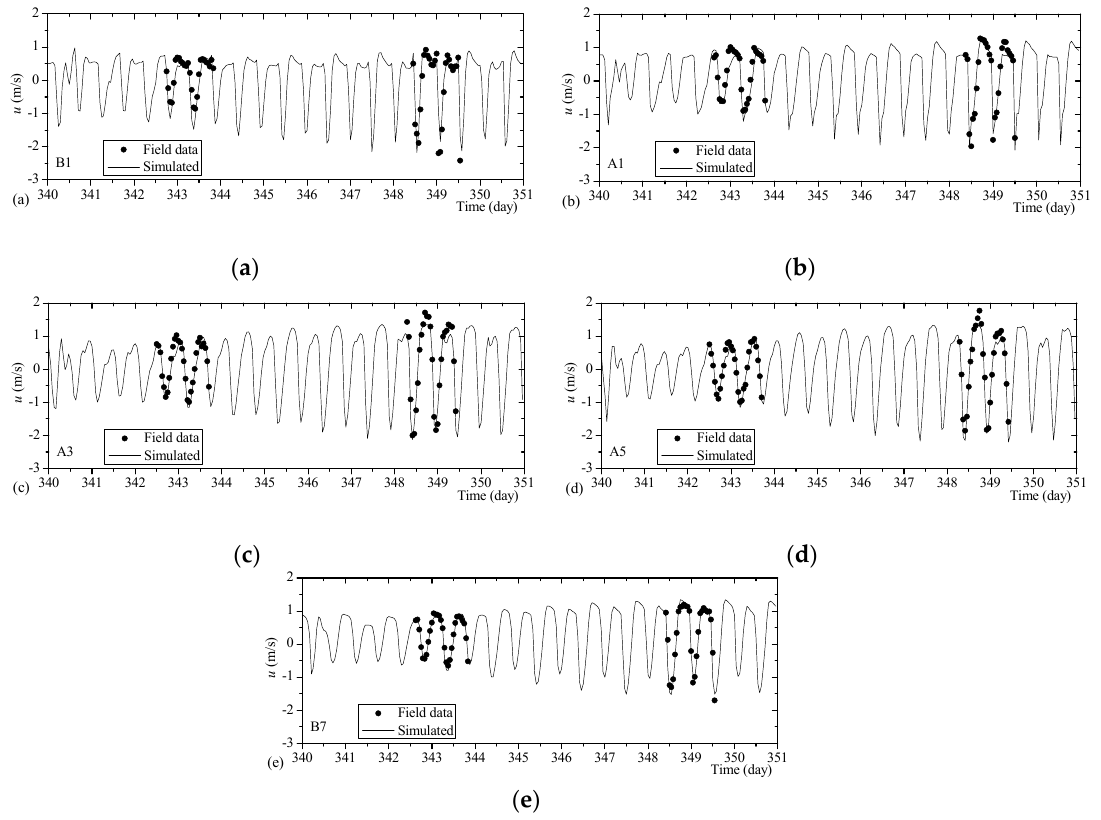
Figure 5. Comparisons of simulated histories of velocity with field data (negative velocity is landward velocity, which appears during the flood duration). ( a ) at Survey Point B1, ( b ) at Survey Point A1, ( c ) at Survey Point A3, ( d ) at Survey Point A5, ( e ) at Survey Point B7.